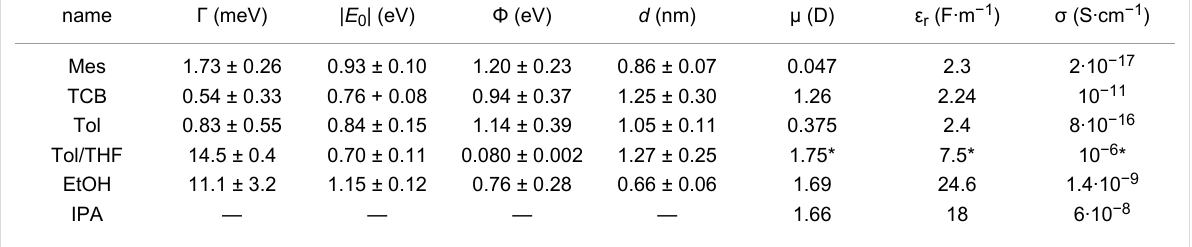
Table 2: Averaged fitting results with SLM and SM, and dielectric properties of pure solvents [42,43]. Here the error ranges denote the statistical error from the averaging over all fit results. The values marked with an asterisk are given for THF. The properties of the respective solvents are: µ the dipole moment, ε r the low frequency dielectric constant, and σ the DC conductivity. Data taken form the Reaxys® data base and references